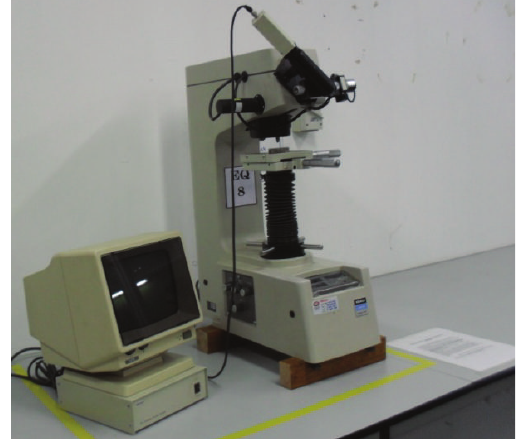
Figure 4: Microhardness tester machine.